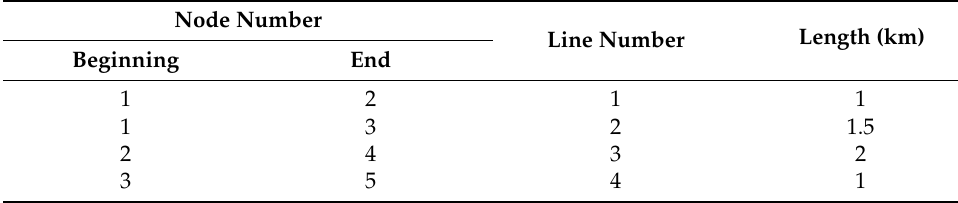
Table 5. Parameters of the pipelines.